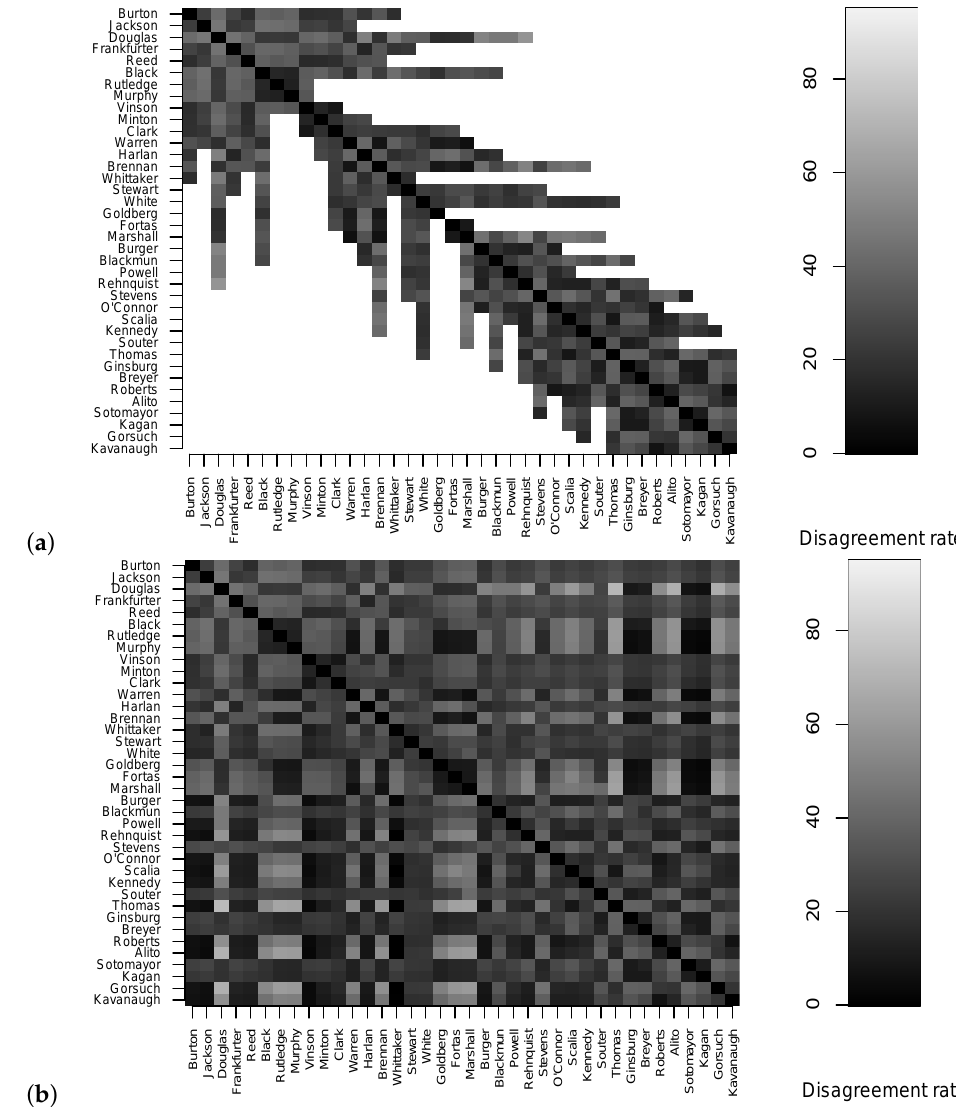
Figure 15. The disagreement matrix for the full 1946–2020 SCDB ( a ) before completion and ( b ) after softImpute matrix completion. Missing entries are plotted white, otherwise lighter shades indicate higher disagreement percentages among the justices (so black means the two justices always agree and light gray that they usually